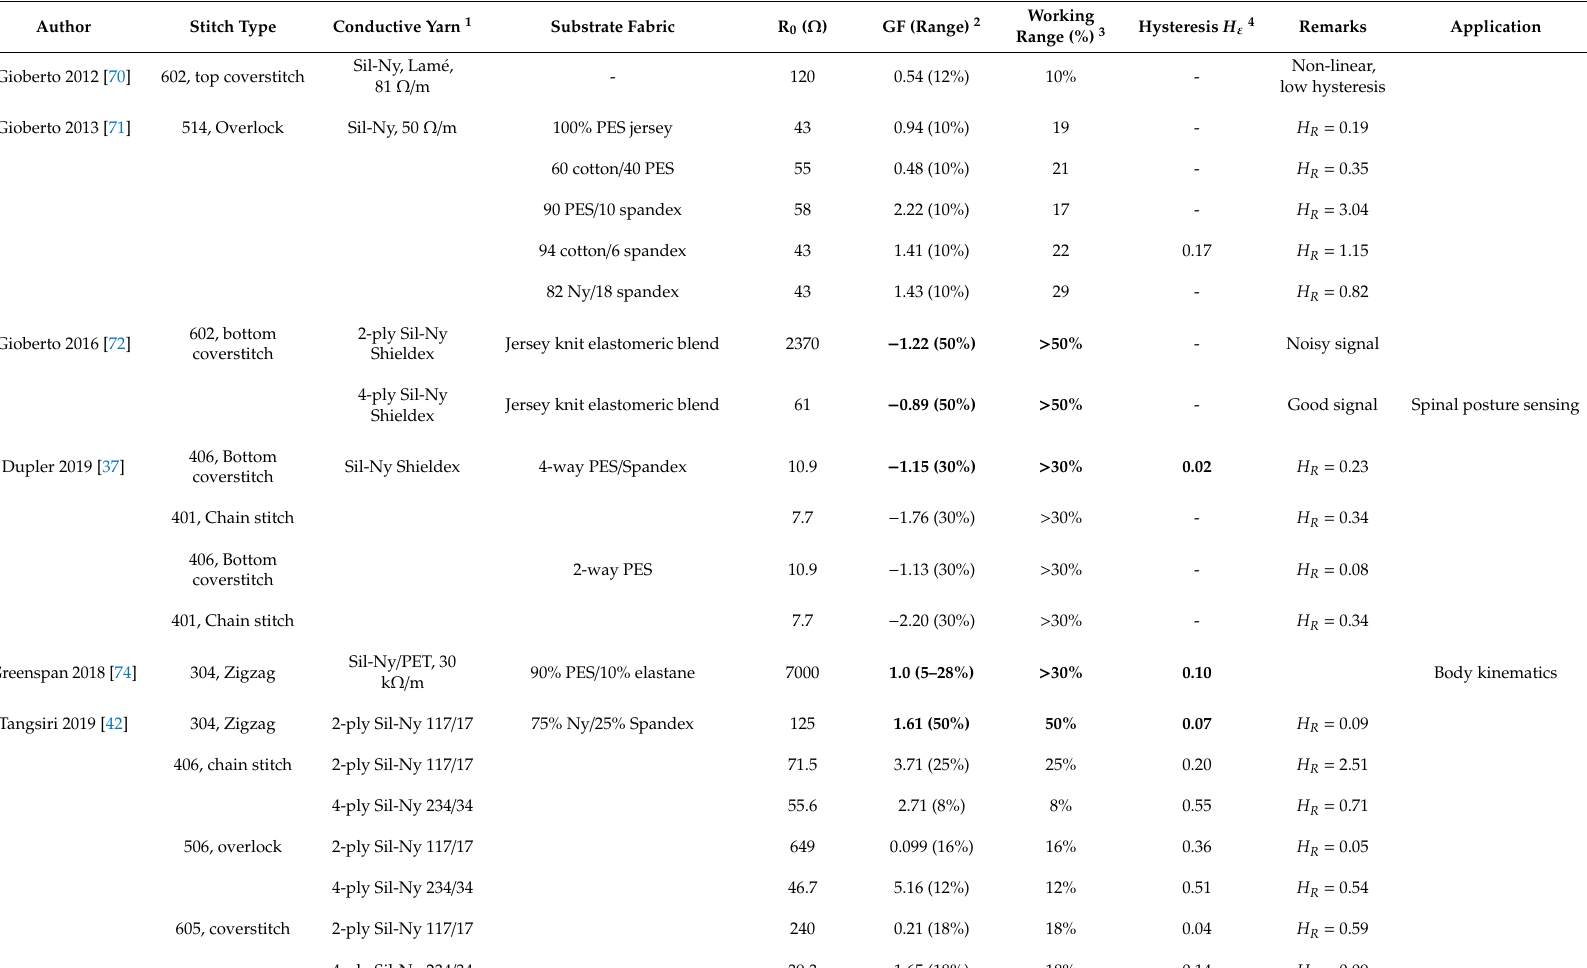
Table 2. Performance comparison of stitched sensors. Sensors with working range above 30% and low hysteresis are